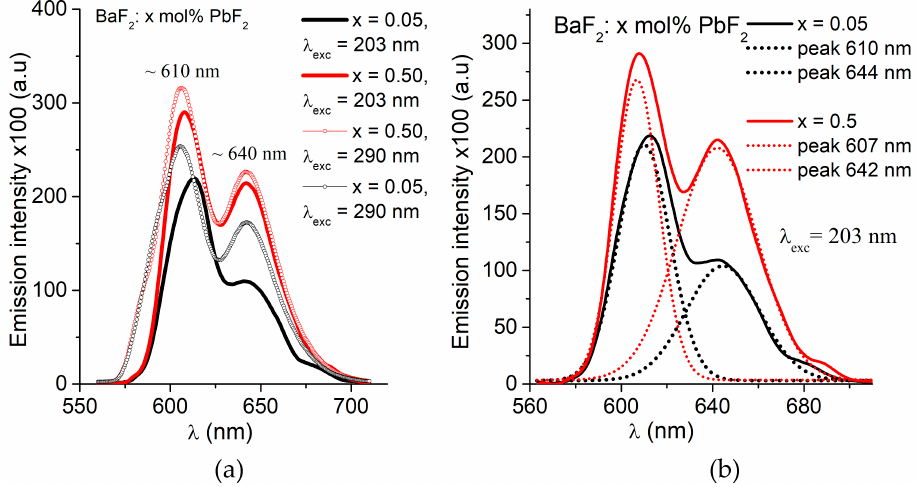
Figure 11. ( a ) In fl uence of the excitation wavelengths, λ exc = 203 nm and 290 nm, on emission inten- sity in the visible domain for two PbF 2 concentration samples; ( b ) Gaussian multi-peak fi tt ing of the emission band in the visible domain, for two samples, by excitation at λ exc = 203 nm.